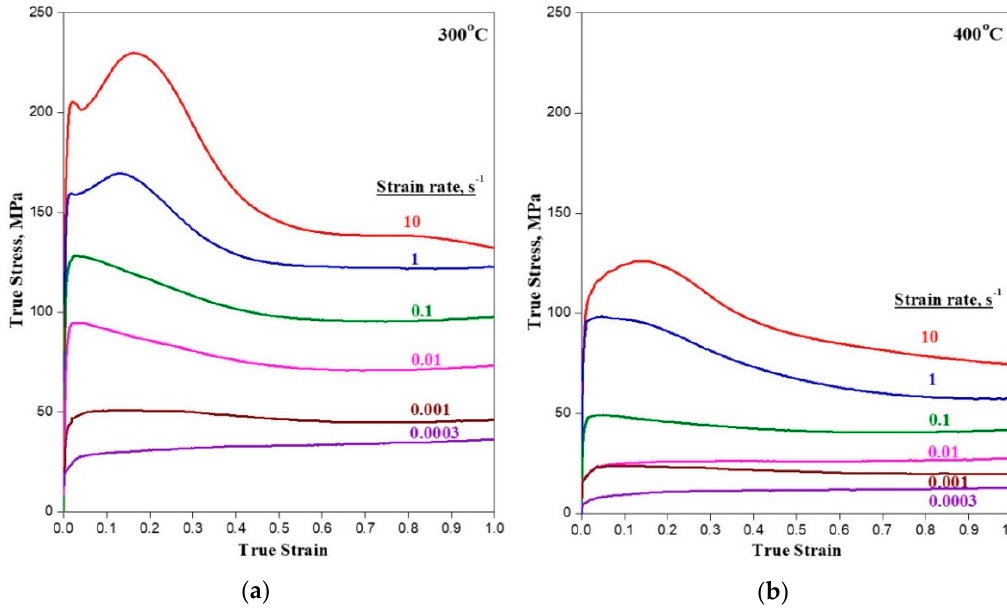
Figure 4. True stress–true strain curves obtained in compression on DMD processed AZ31-3Ca alloy at different strain rates at temperatures of ( a ) 300 ° C, and ( b ) 400 ° C.